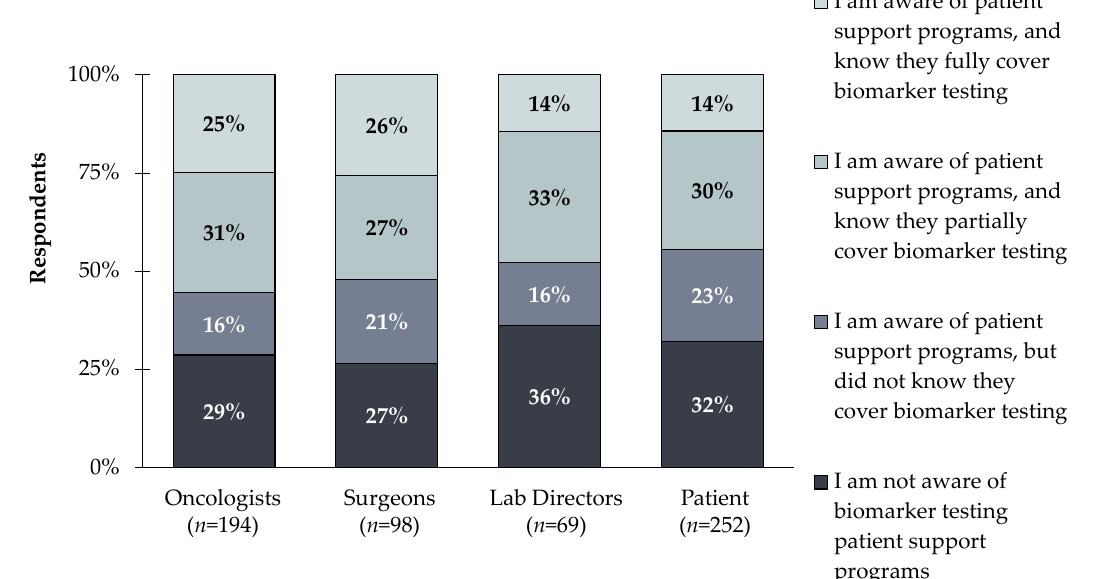
Figure 6. Oncologists, surgeons, lab directors, and patients ( n = 613) were asked the following ques- tions: Which of the following best describes your level of awareness of patient support programs for biomarker testing? A large amount of all respondents reported not being aware of biomarker testing patient support programs (29% of oncologists, 27% of surgeons, 26% of lab directors, and 32% of patients).